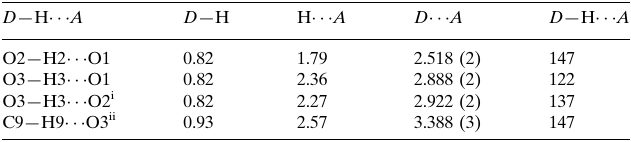
Hydrogen-bond geometry (A˚ , (cid:2)